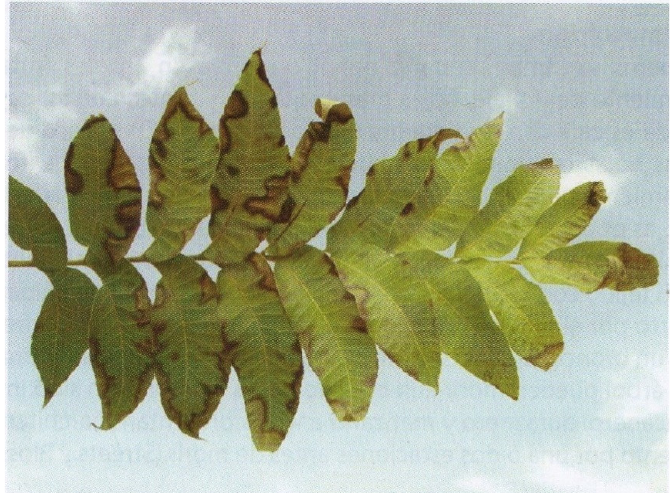
Figure 1. Wilting (bronzing) and leaf necrosis of pecan trees affected by phymatotrichopsis root rot